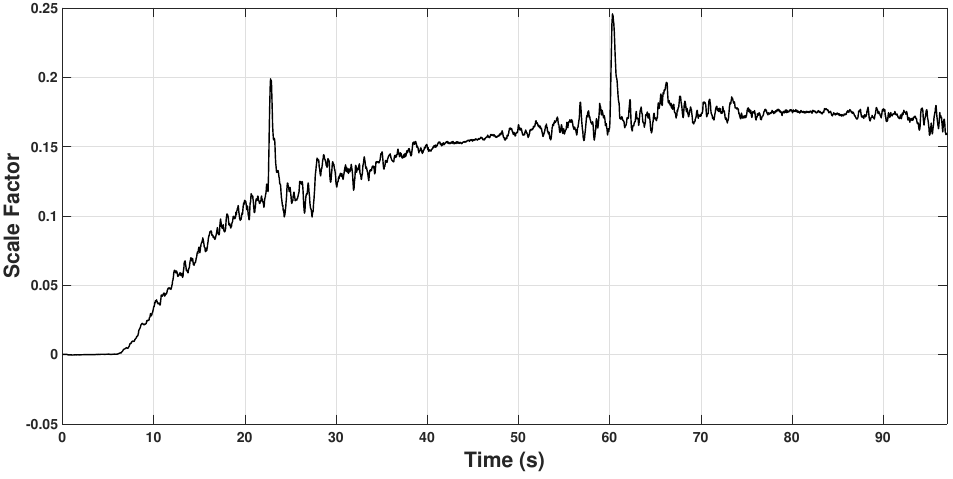
Figure 8. Estimated scale factor β 2 x on the X i